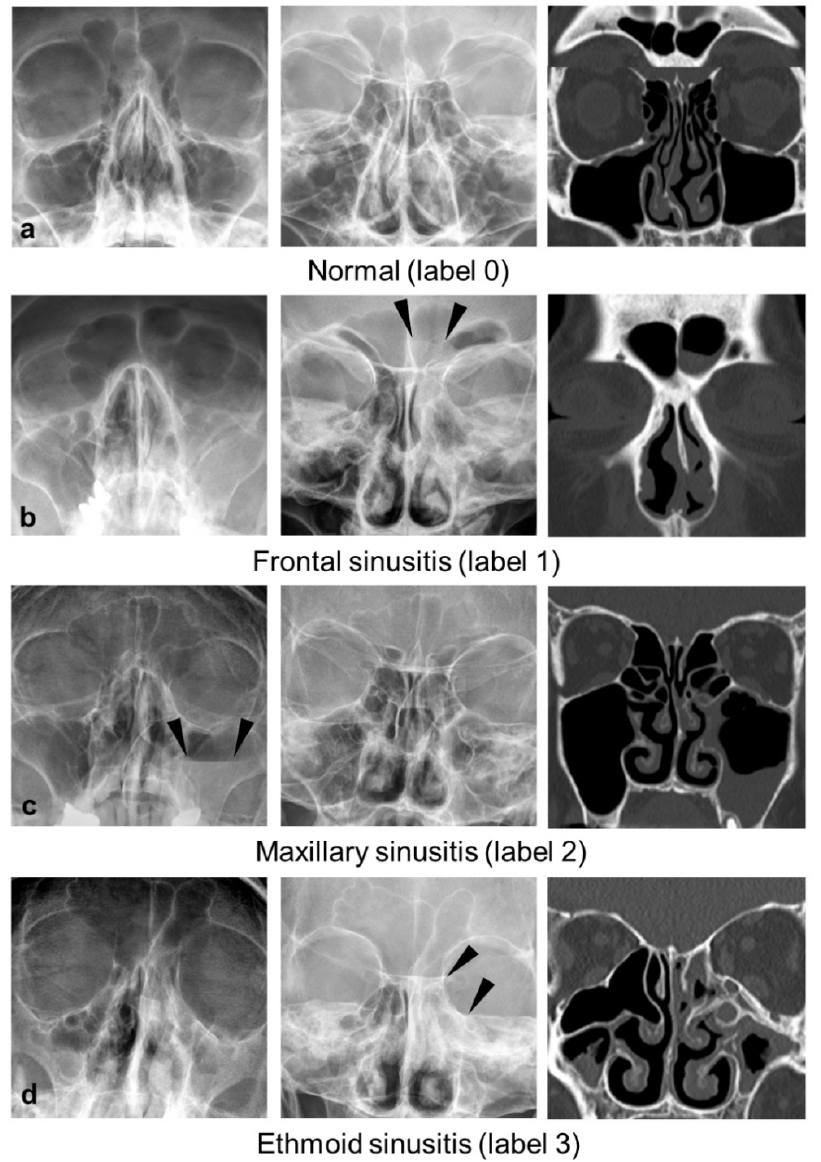
Figure 2. Representative cases with normal (label 0, a ), frontal sinusitis (label 1, b ), maxillary sinusitis (label 2, c ), and ethmoid sinusitis (label 3, d ) at each view (Waters’ view: left, Caldwell view: middle, corresponding coronal image of CT, right). For frontal ( b ) and ethmoid sinusitis ( d ), mucosal thickening (label 1) and total opacification (label 3) are not well visualized in Waters’ view, whereas Caldwell view provides the best projection for evaluation (arrowheads). In the case of maxillary sinusitis ( c ), Waters’ view provides a better view of the air-fluid level (label 2, arrowheads) than Caldwell view.